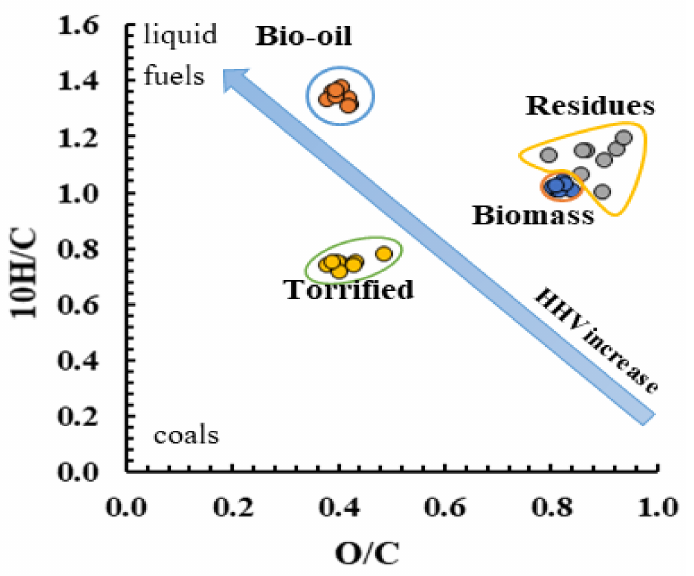
Figure 3. Van Krevelen diagram comparing the H/C and O/C ratios of biomass, solid residues, torrefied biomass, and bio-oils.